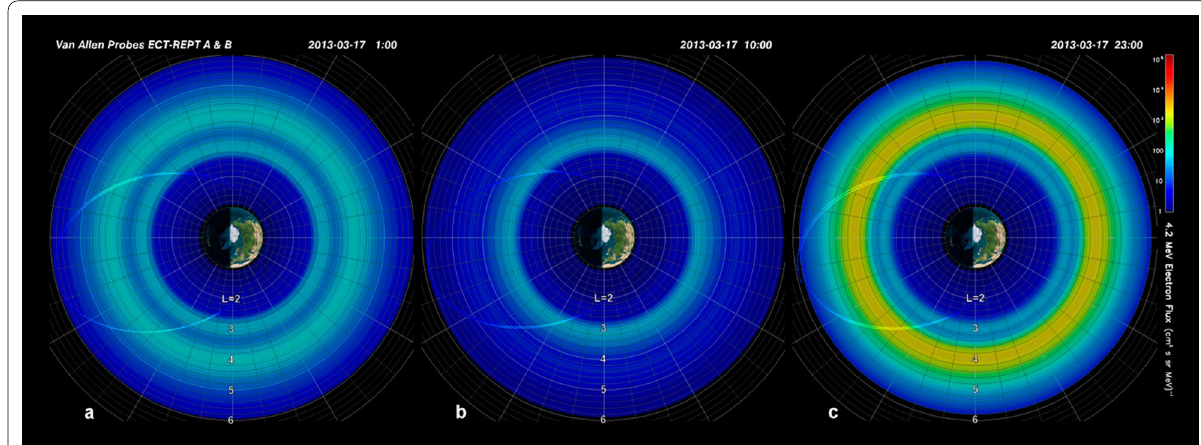
Fig. 5 Polar plots of electron fluxes for 4.2-MeV channel for 17 March 2013. a Pattern for ~ 0100 UT. b For ~ 1000 UT. c For ~ 2300 UT for times shown (from REPT Relativistic Electron–Proton Telescope) (From Baker et al. =